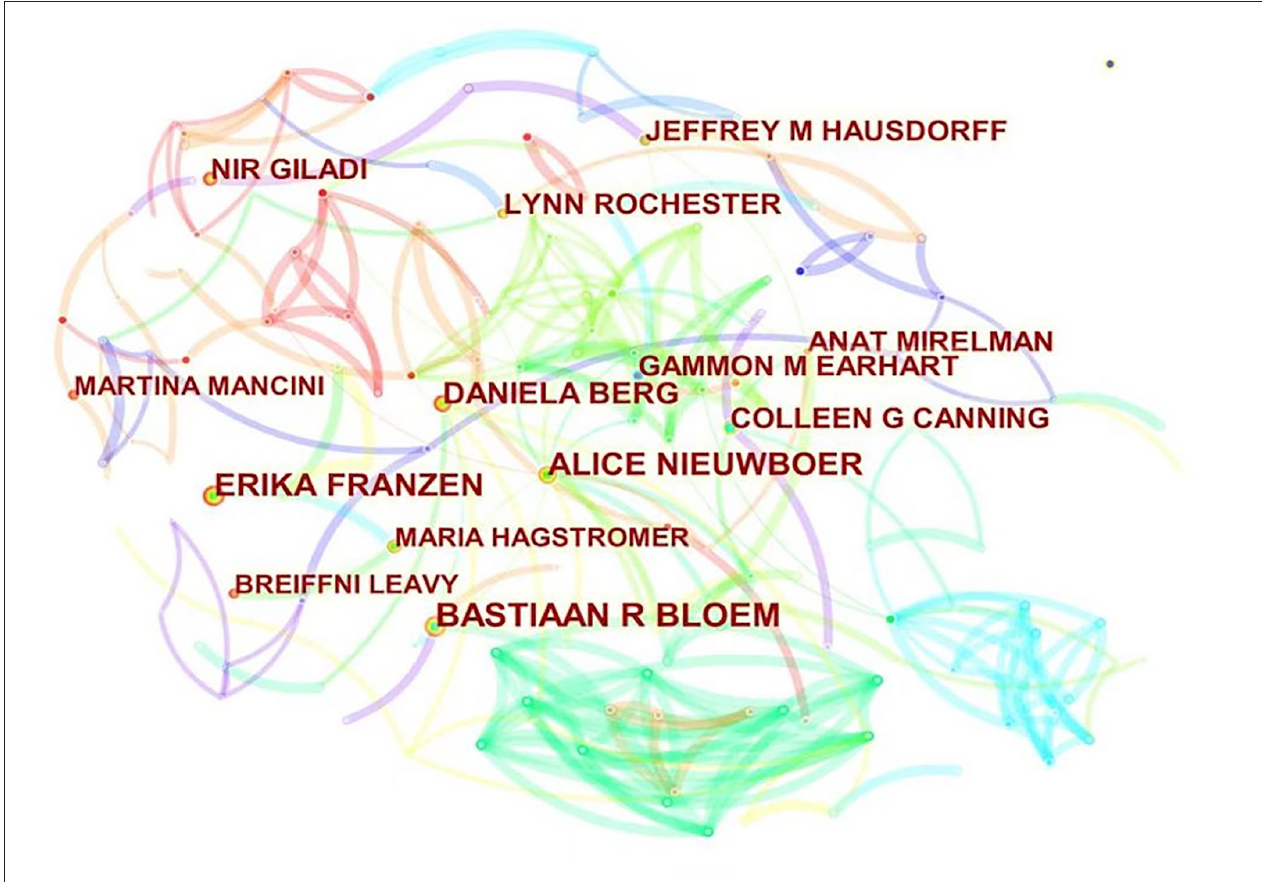
FIGURE 6 | Network graph of the relationship between authors related to the research of exercise on